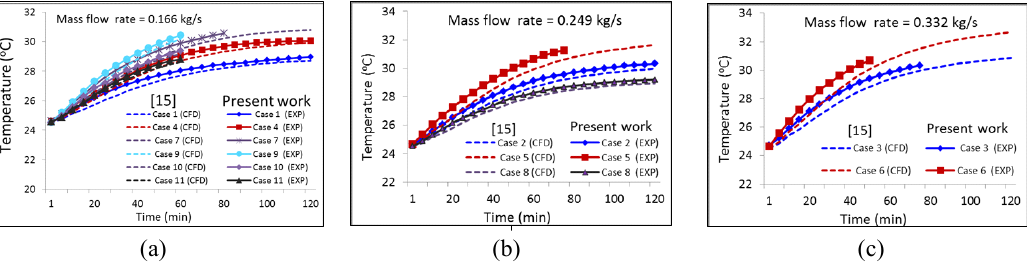
Figure 11. Comparison of the average temperature of the water in the tank in the experimental and simulation results. Mass flow rate inlet of the HCT: ( a ) 0.166 kg/s, ( b ) 0.244 kg/s, and ( c ) 0.332 kg/s.